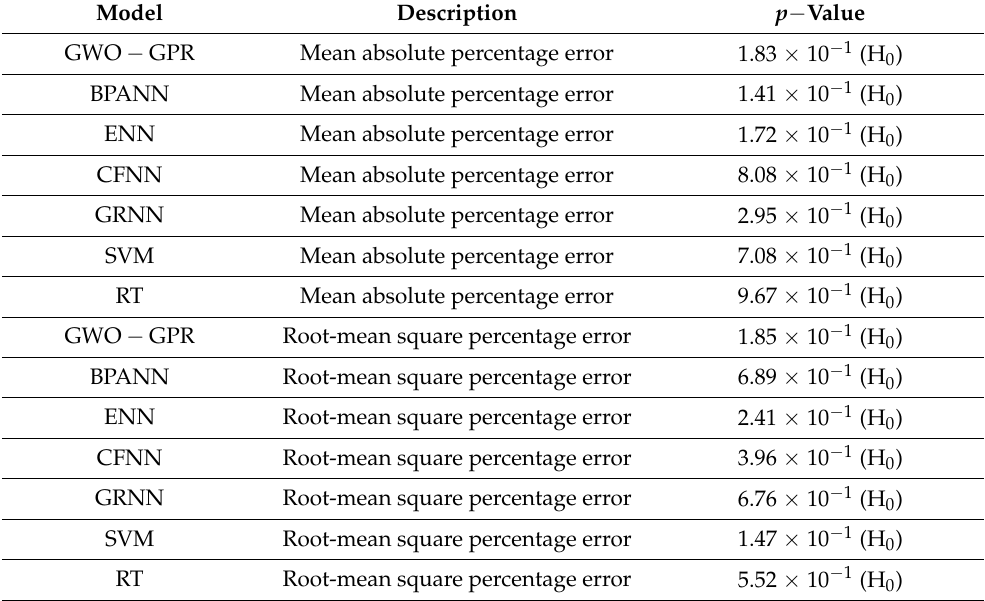
Figure 9. Rankings of the deterioration models of concrete portal. Table 8. p − values of some performance indicators of the deterioration models using the Shapiro– Wilk test for